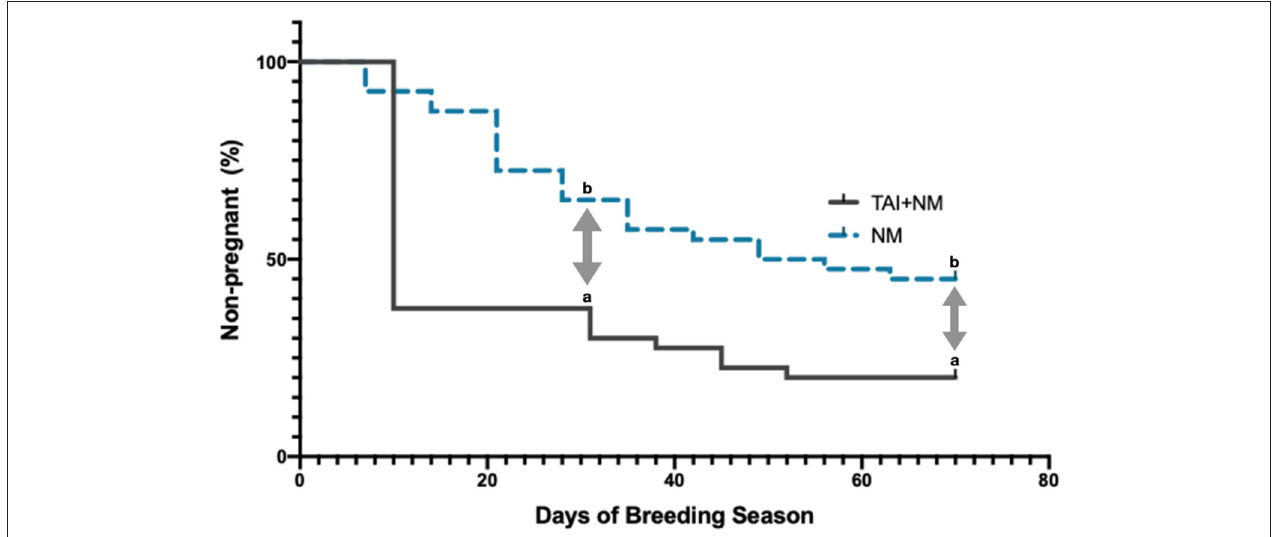
FIGURE 4 | Kaplan-Meier survival curves for pregnancies by breeding program. Different letters indicated by double-headed arrows are statistically significant ( P < 0.01).